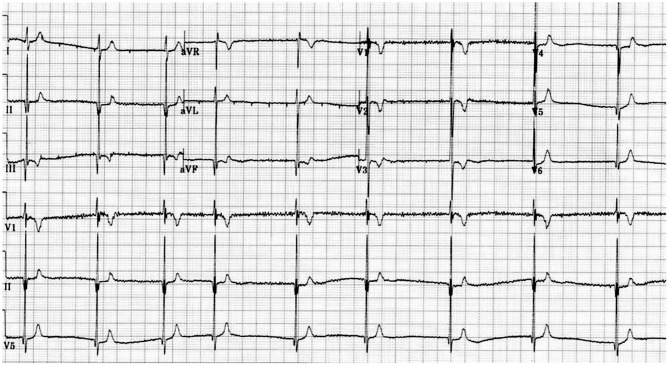
Electrocardiogram showing a short QT interval.